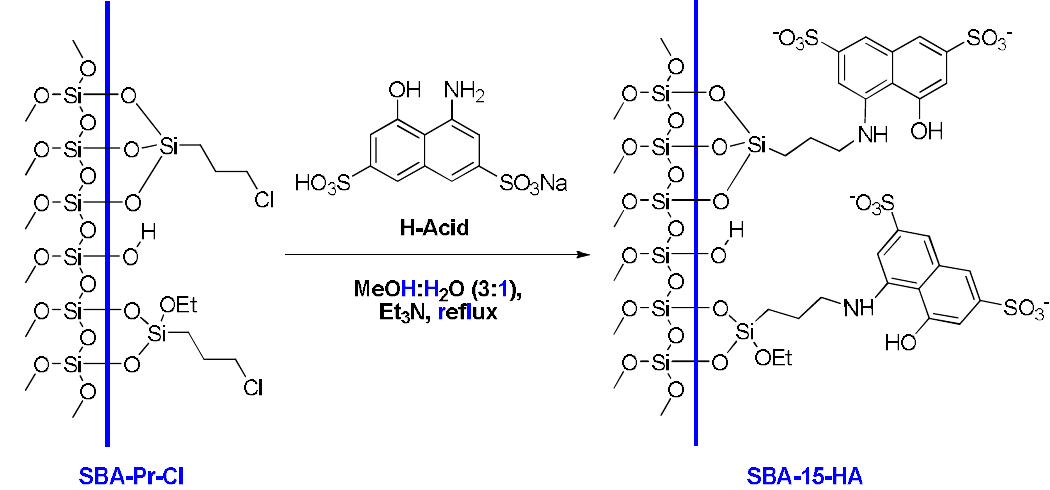
Fig. 16. Schematic representation of SBA-15-HA synthesis procedure.